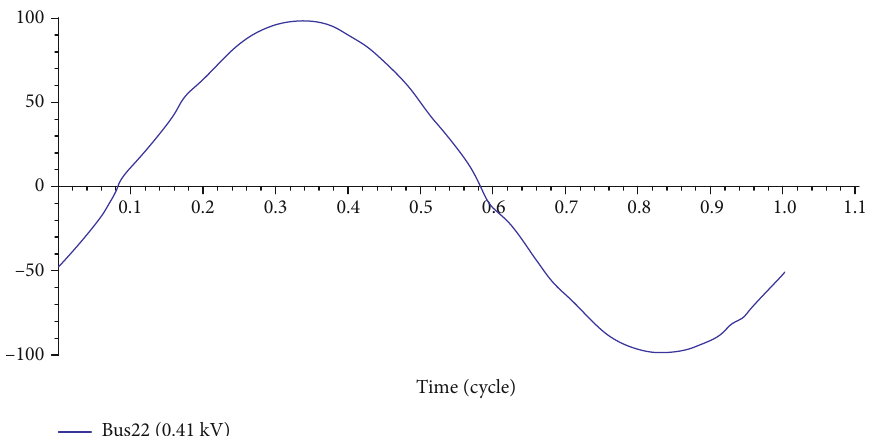
Figure 6: Output wave representation at PV